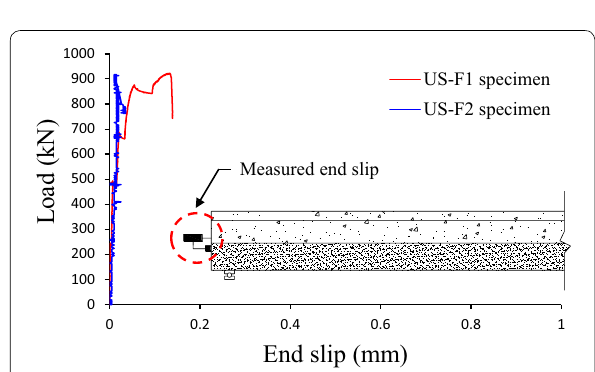
Fig. 11 Measured end slip behaviors between prestressed concrete bottom flange and surrounding CIP